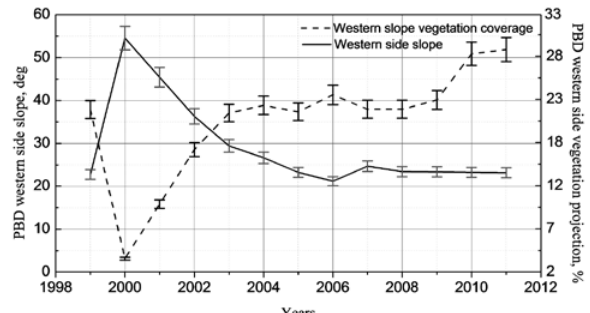
Fig. 8. Changes of the PBD western side slope and vegetation